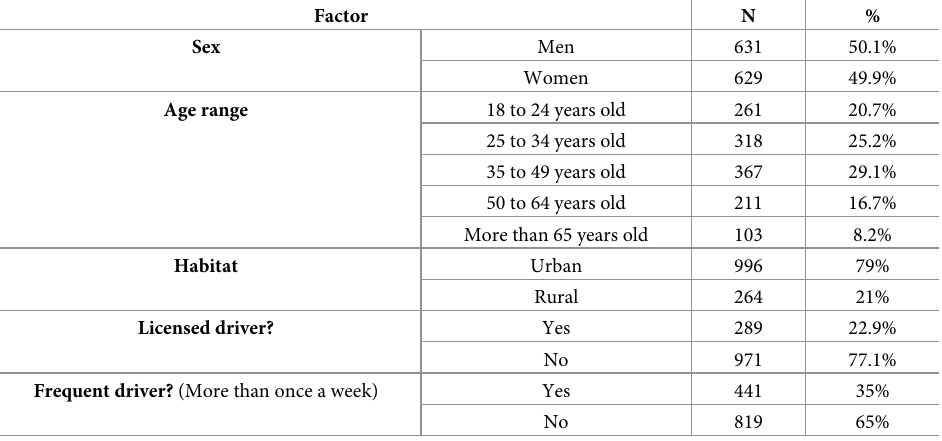
Table 1. Sociodemographic data of the study